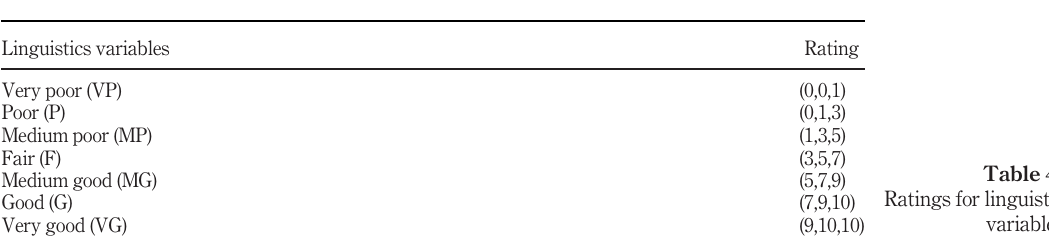
Table 4. Ratings for